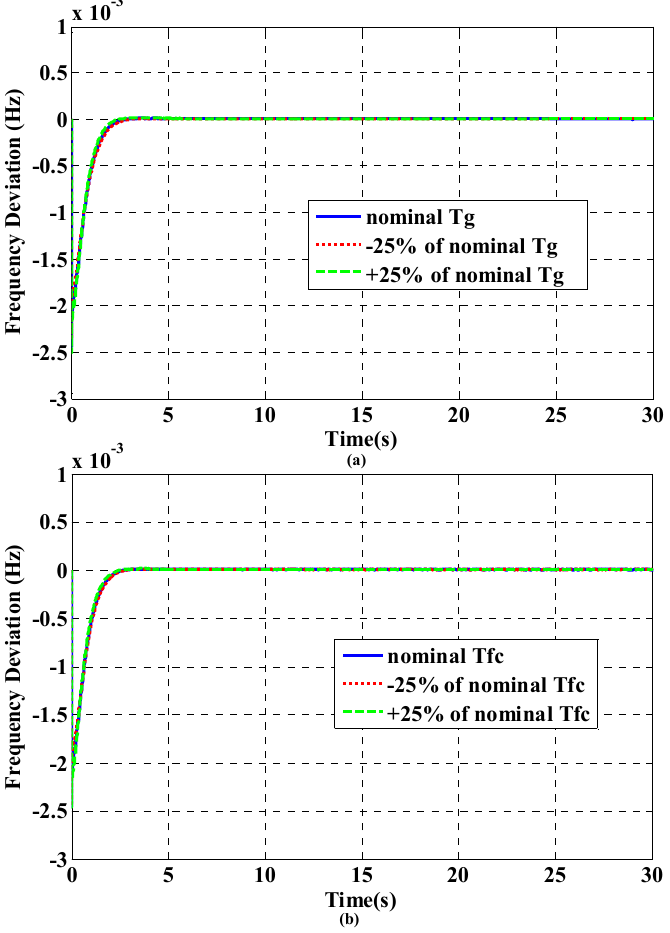
Figure 17. Sensitivity analysis of the MG by employing the proposed controller during ±25% variations in ( a ) T g and ( b ) T FC .